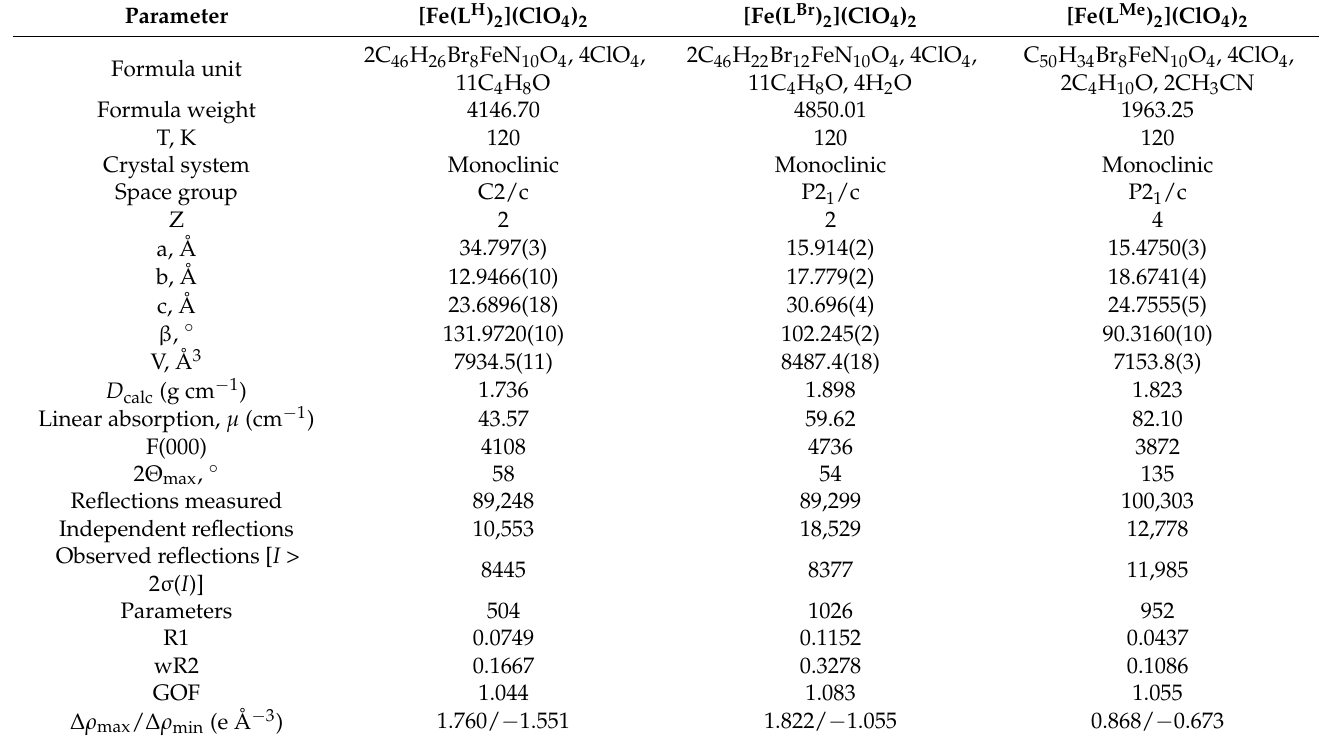
Table 1. Crystal data and structure refinement parameters for [Fe( L H ) 2 ](ClO 4 ) 2 , [Fe( L Br ) 2 ](BF 4 ) 2 and [Fe( L Me ) 2 ](ClO 4 ) 2 .